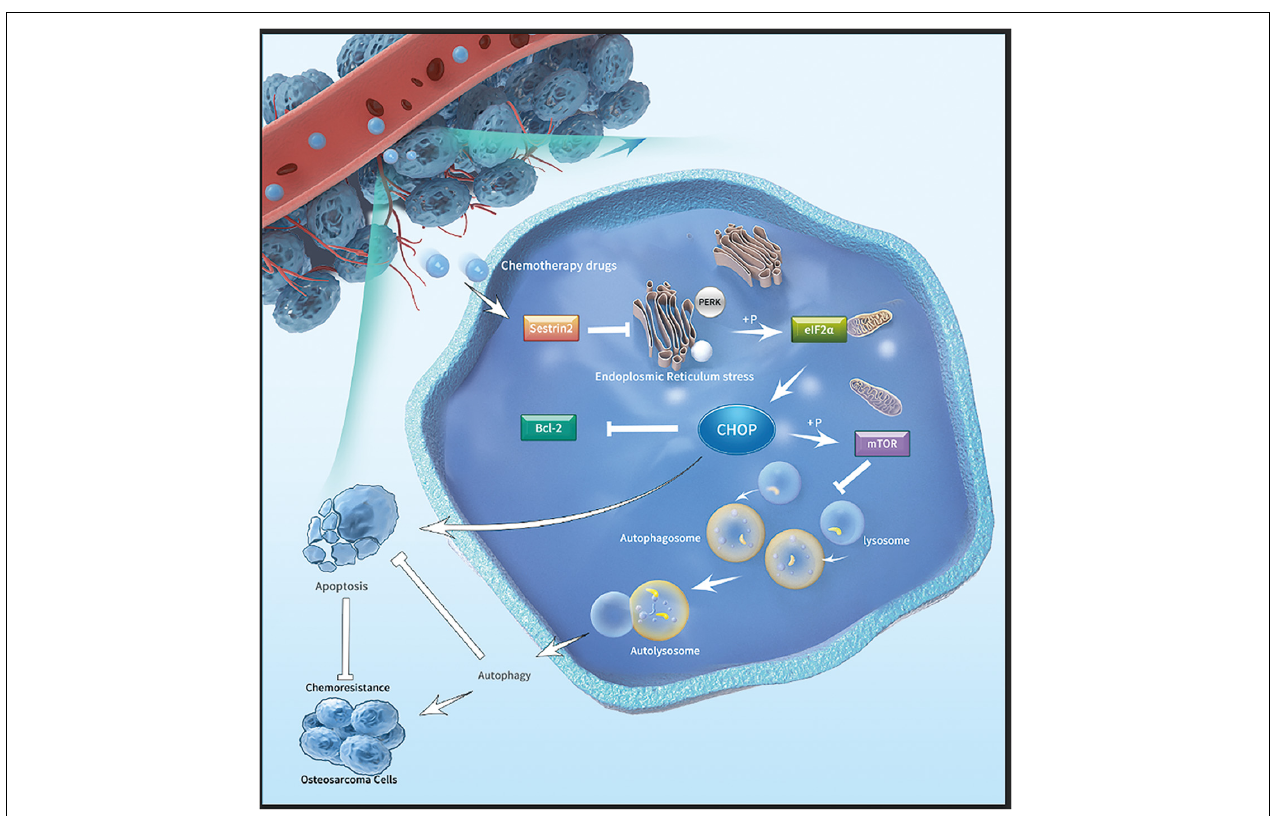
FIGURE 7 | Mechanistic model depicting the effects of SESN2 on the drug resistance of osteosarcoma. After chemotherapy drugs are applied to osteosarcoma cells, SESN2 expression is increased, and the phosphorylation of eIF2 α by PERK during ER stress is inhibited. Finally, the expression of CHOP is suppressed, and apoptosis and autophagy are regulated by Bcl-2 and mTOR, respectively, thus causing drug resistance in osteosarcoma